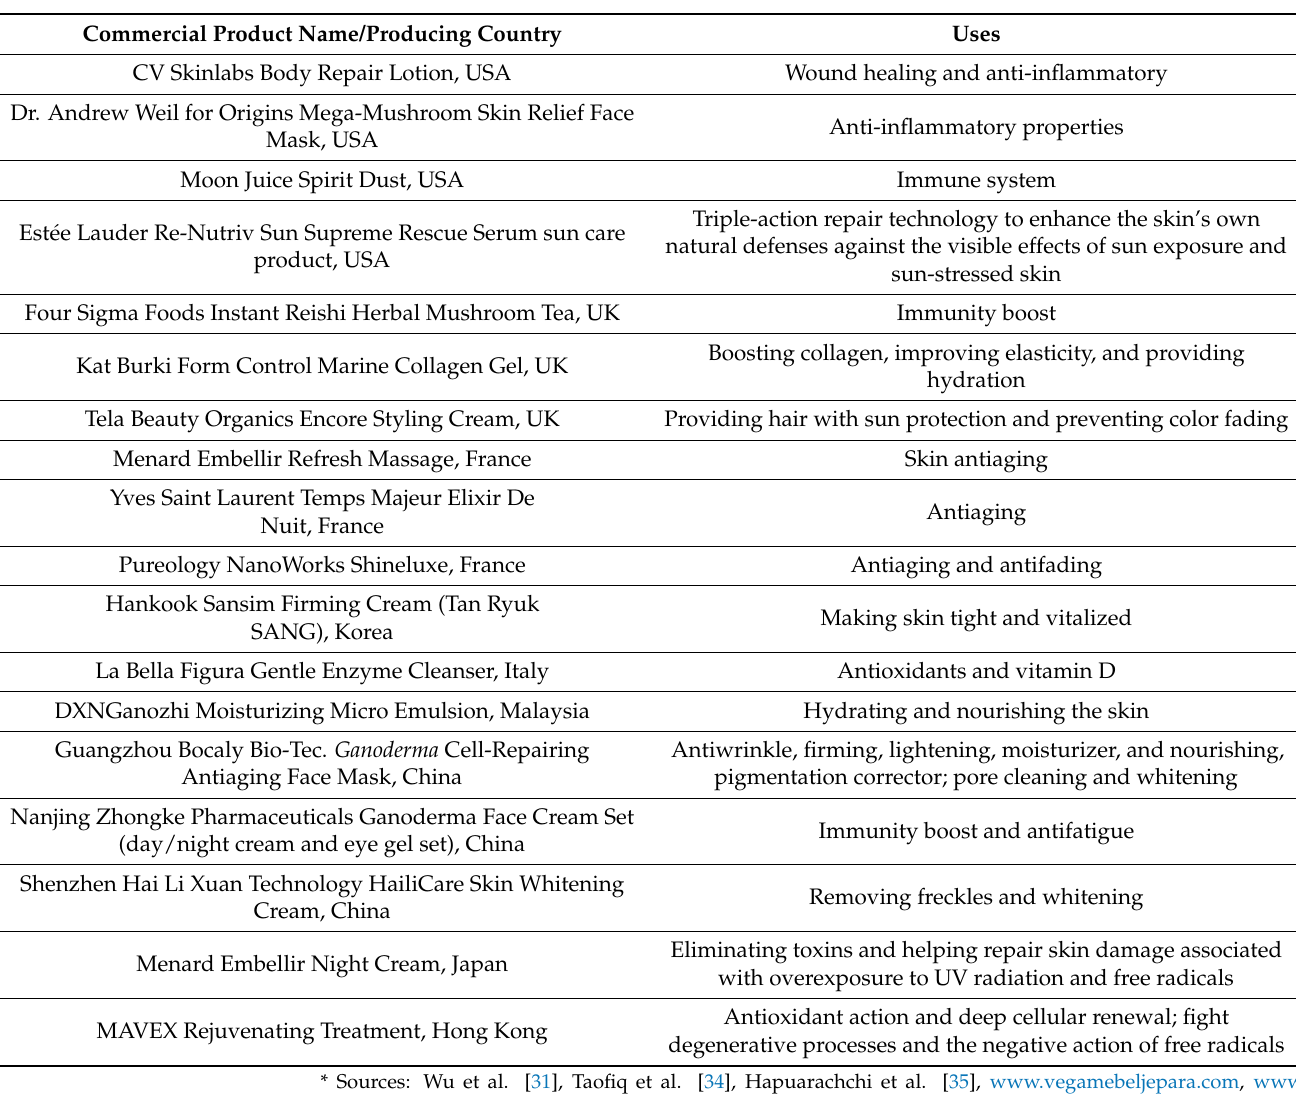
Table 1. Some of the cosmetic products are produced commercially from the G . lucidum mushroom worldwide